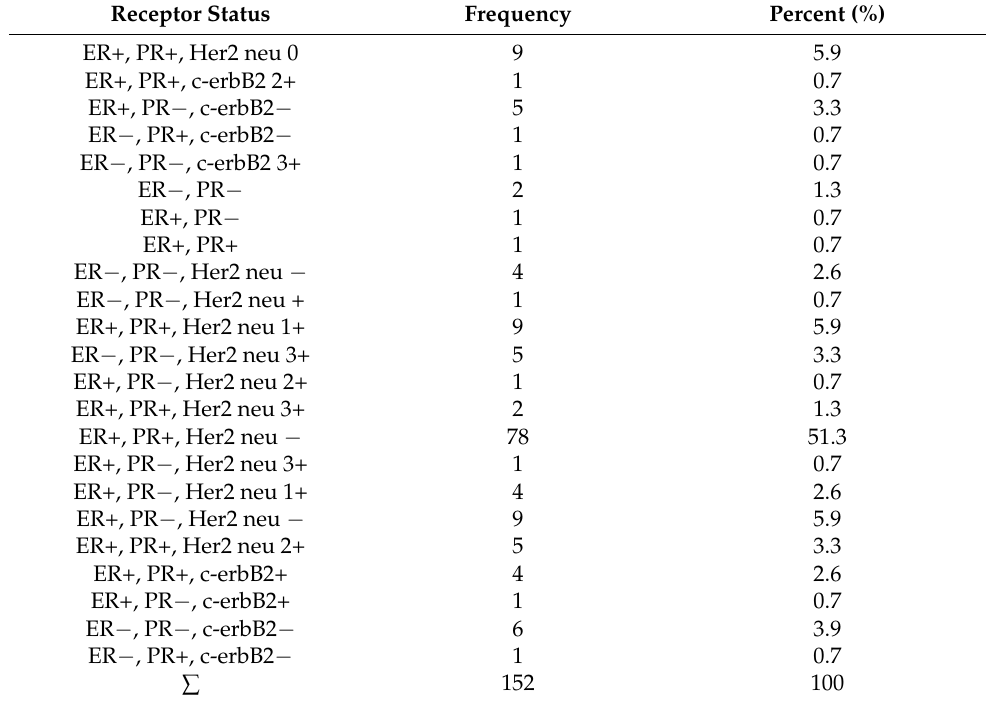
Table 2. Distribution of receptor status in the